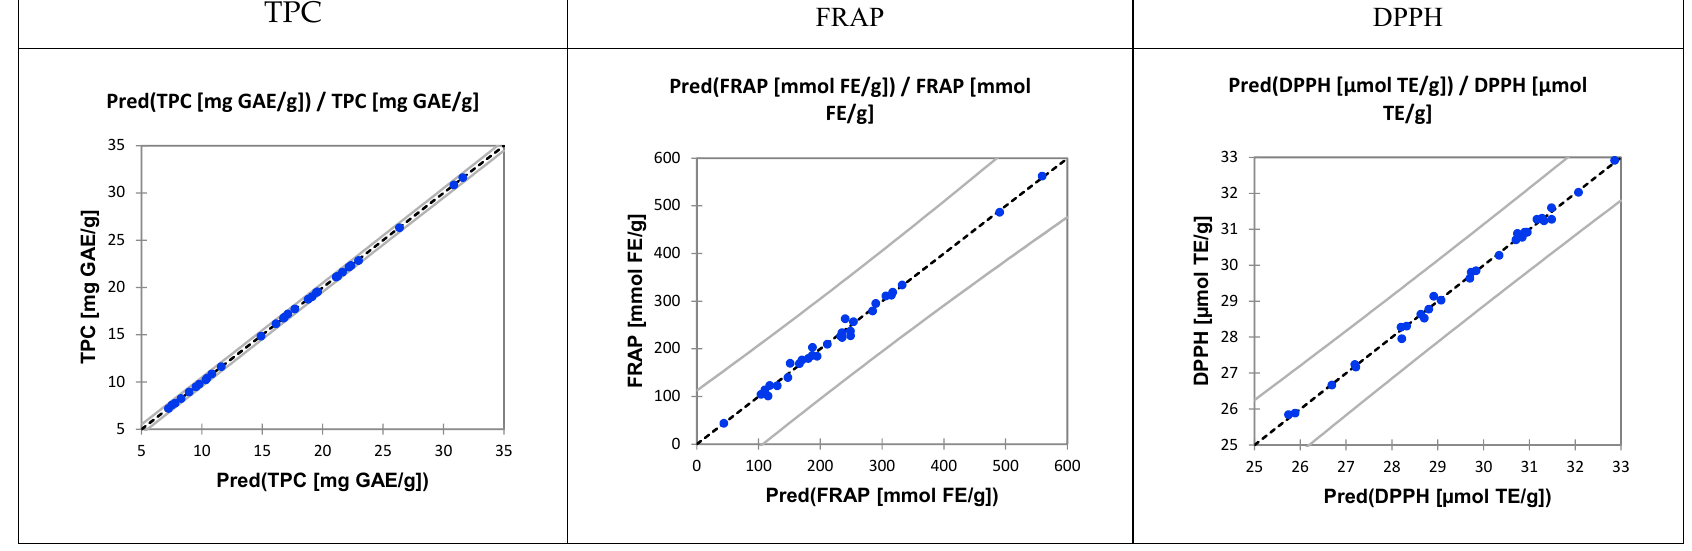
Table 4. International Commission on Illumination (CIE)—L*a*b* color parameters of CE and HVED treated rosemary extracts.